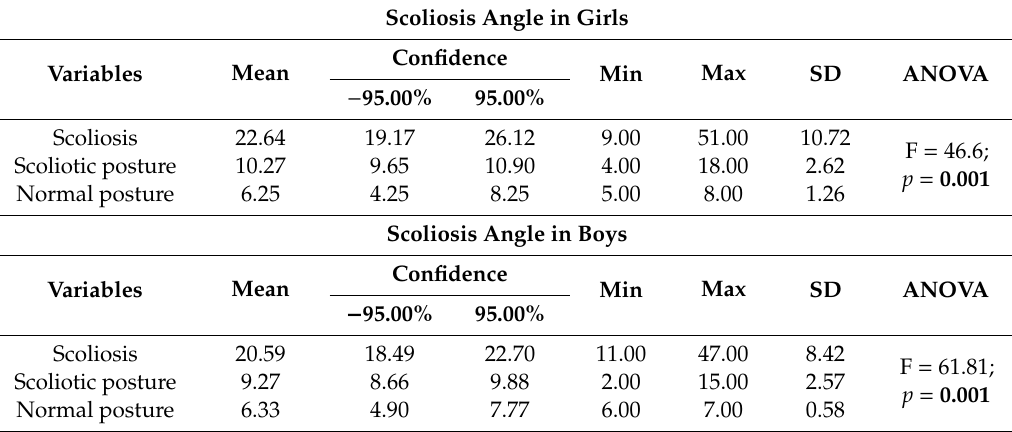
Table 1. Di ff erences in one-way Analysis of Variance (ANOVA) among scoliosis angle in girls and boys. Scoliosis Angle in